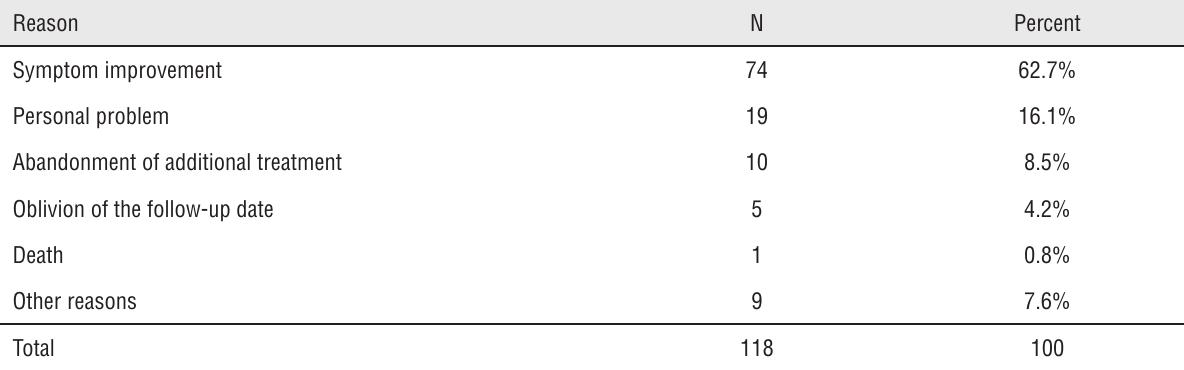
Table 5 - Reasons for follow-up loss after the mid-urethral sling